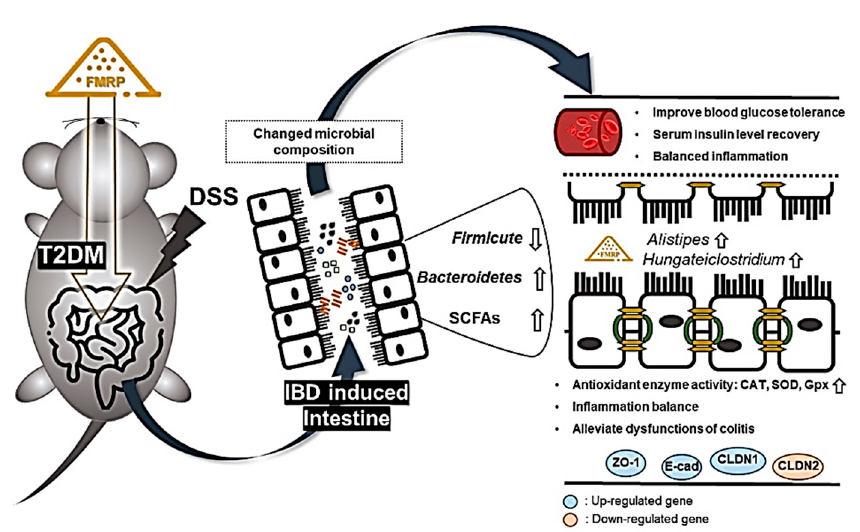
Figure 8. Scheme depicting the proposed mechanisms for improving type 2 diabetes (T2DM) dys- functions associated with inflammatory bowel disease (IBD) through microbiota intestinal changes in FMRP administration. The ↑ denotes up-regulation and the ↓ means down-regulation.